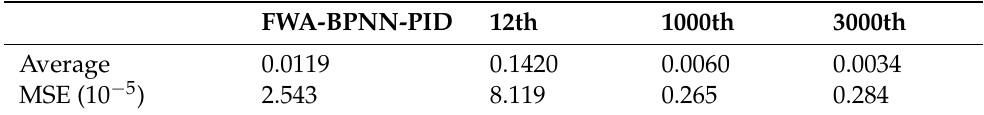
Table 2. Training error data of data-driven control method based on DDPG.